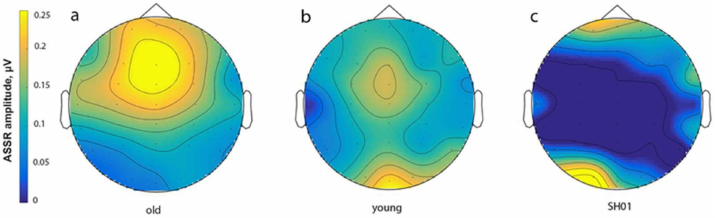
Figure 4. Topographic map of 40-Hz ASSR amplitude averaged over the period of 0–500 ms. The “old” group is represented in ( a ), the “young” group is represented in ( b ), and the values of SH01 are represented in ( c ).